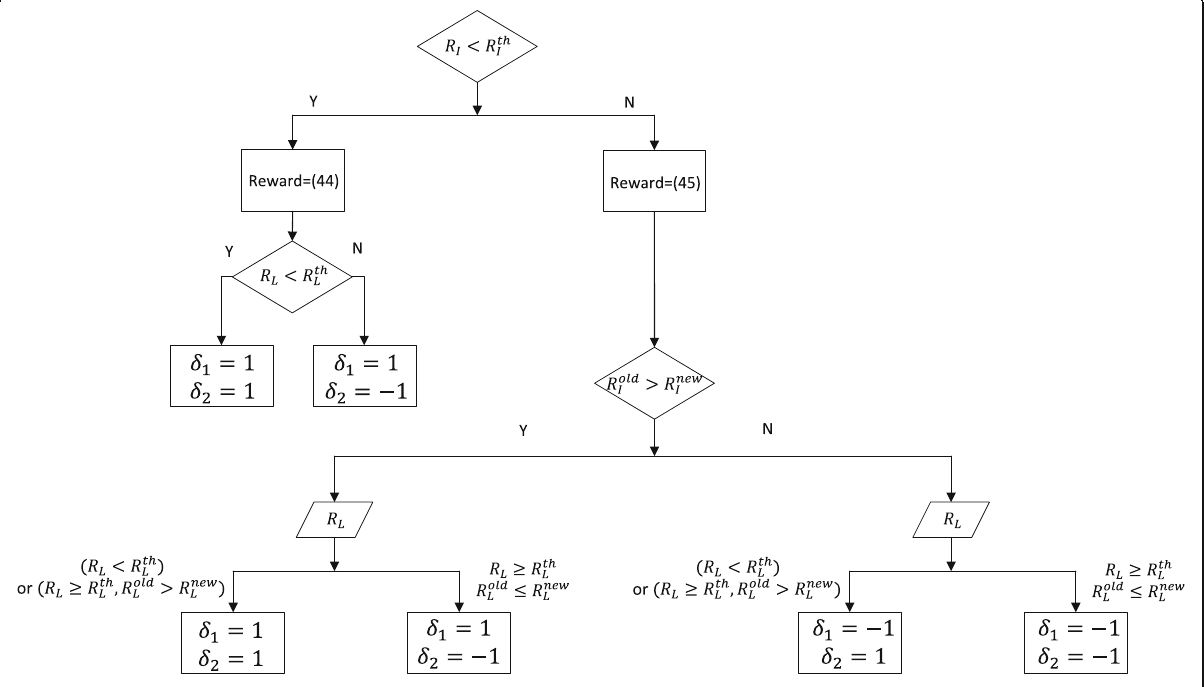
Fig. 9 Flow chart for reward function. We use (27) or (26) for the reward function depending on whether the interference ratio meets the constraint. If (27) is used, the sign of the parameter changes depending on whether or not the transmission opportunity loss ratio satisfies the restriction condition. If (26) is used, the sign of the parameter is changed according to the tendency of whether the interference ratio is improved or deteriorated. After that, the sign of the parameter is changed according to the tendency of the transmission opportunity loss ratio is improved or not for each divided case